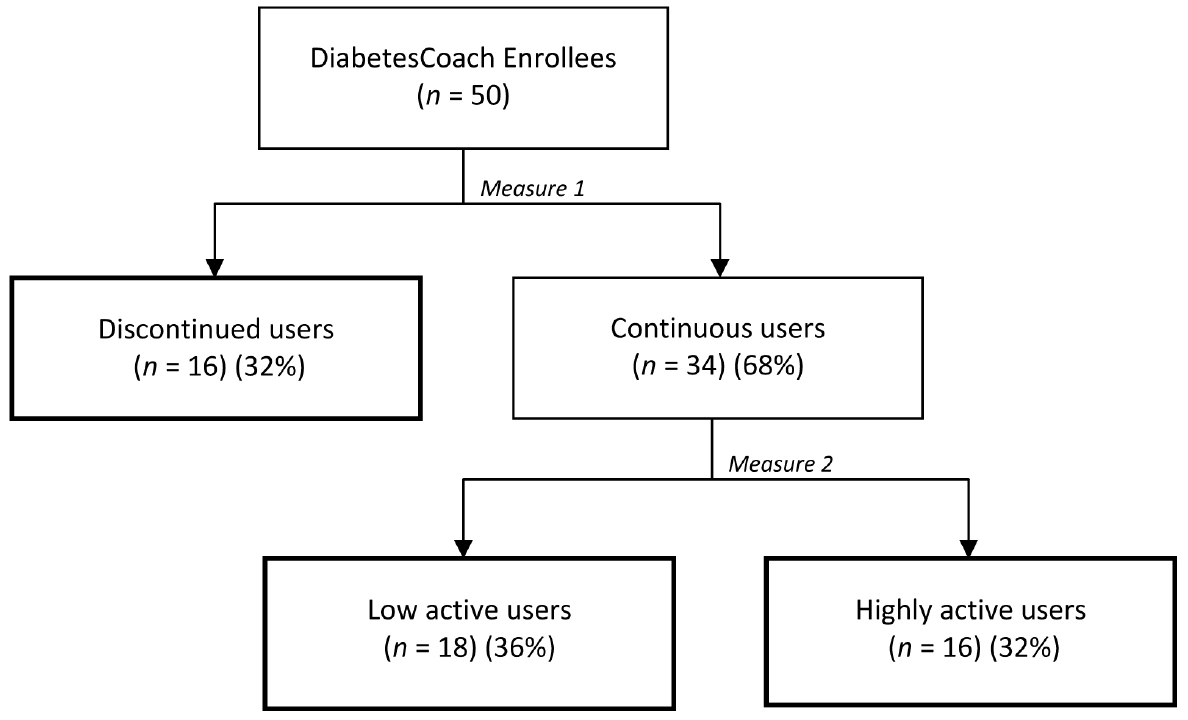
Figure 4. User activity of DiabetesCoach